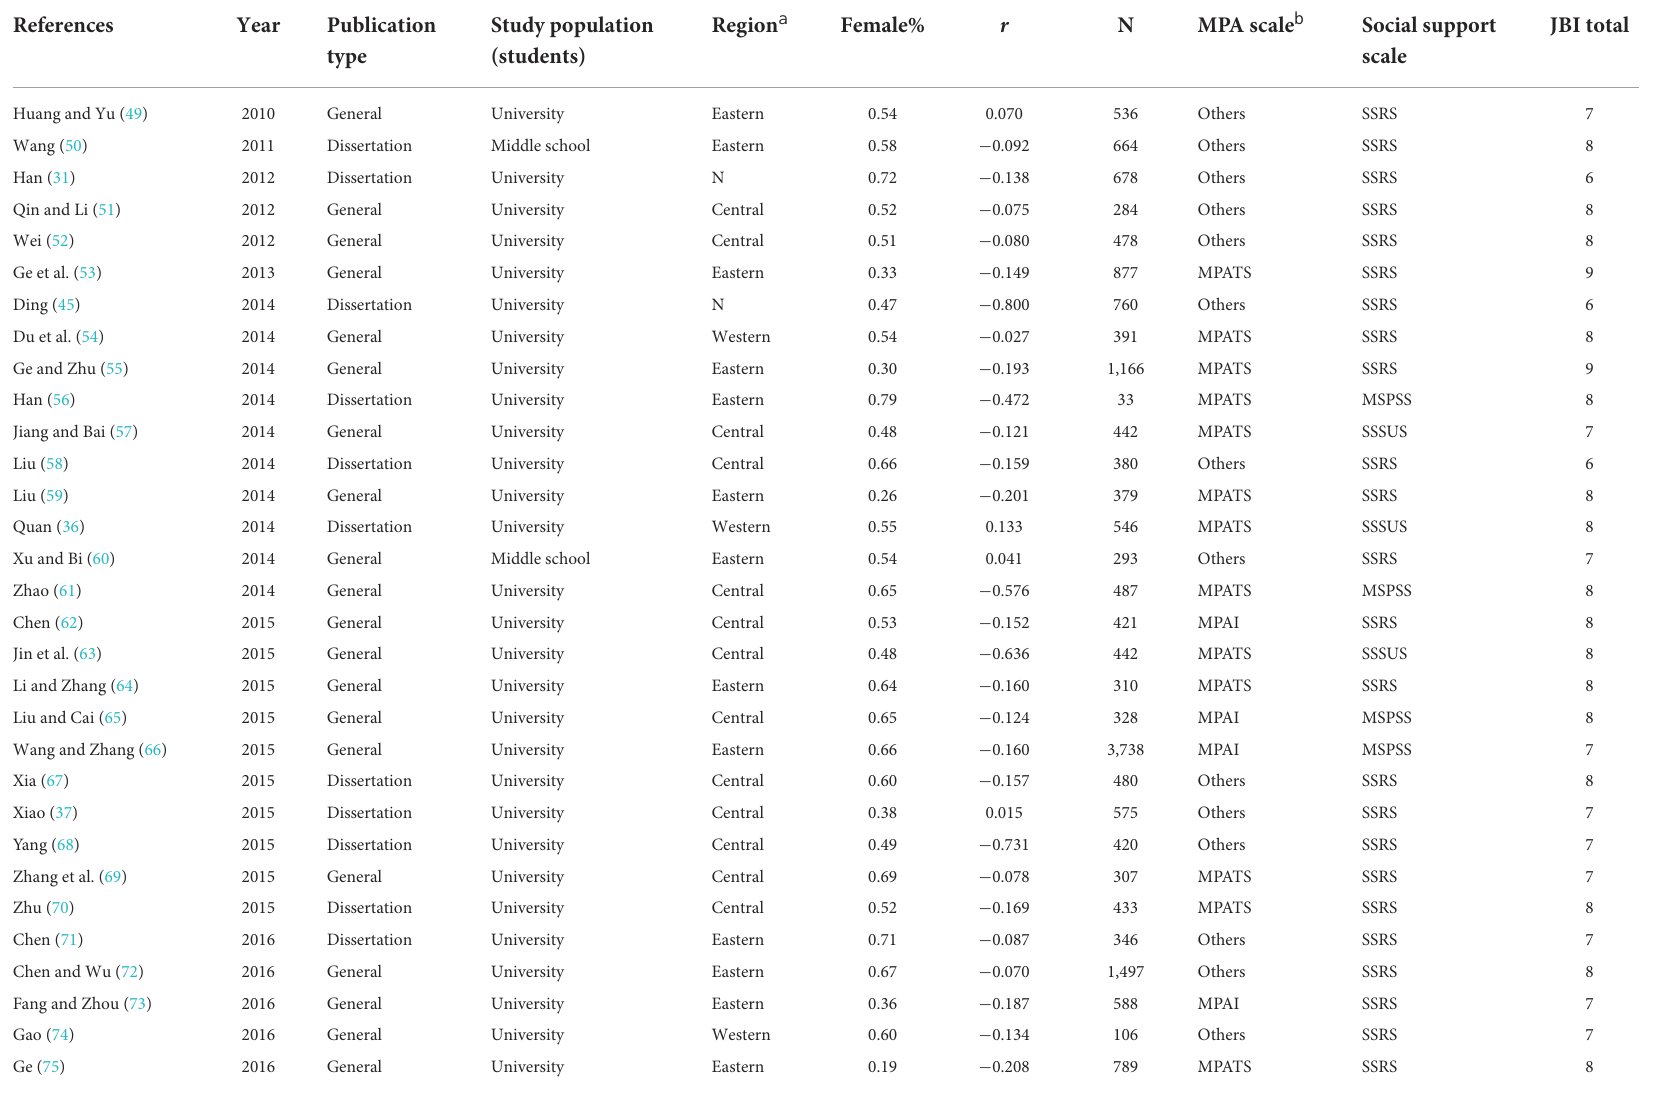
TABLE 2 Characteristics of the 92 studies included in the